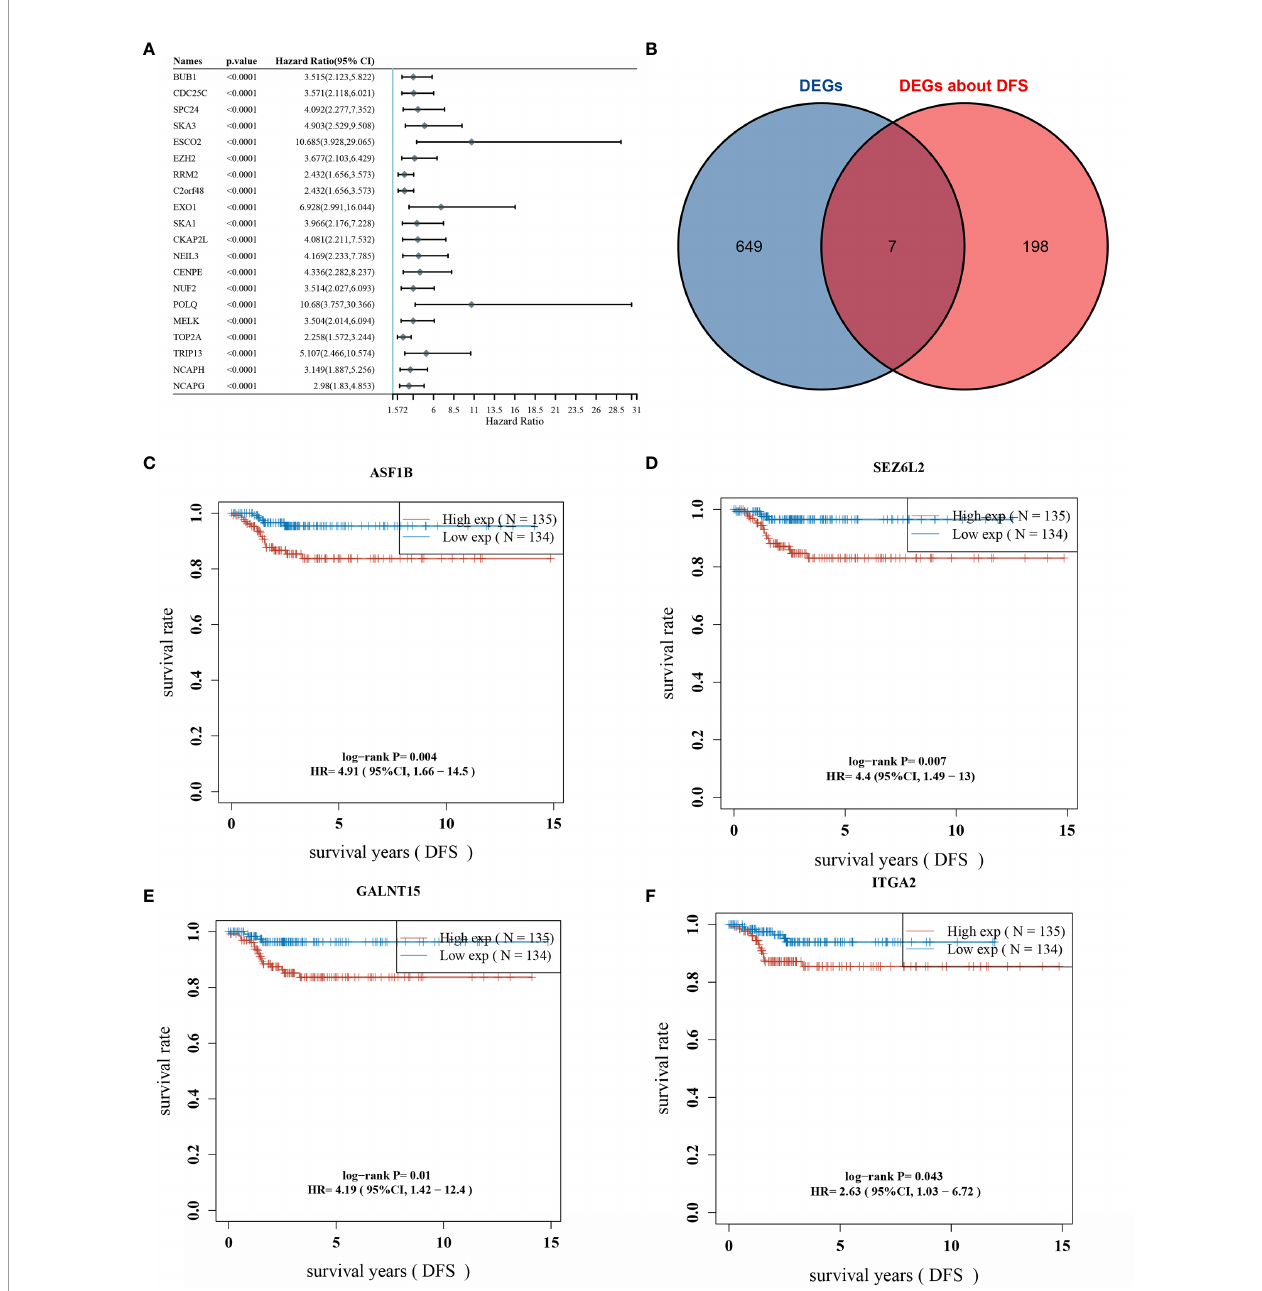
FIGURE 2 | Overlap of differentially expressed genes and prognostic genes; (A) top 20 genes associated with DFS (disease-free survival) are shown; (B) overlap of DEGs and prognostic genes; (C) DFS survival curve of ASF1B; (D) DFS survival curve of SEZ6L2; (E) DFS survival curve of GALNT15; (F) DFS survival curve of